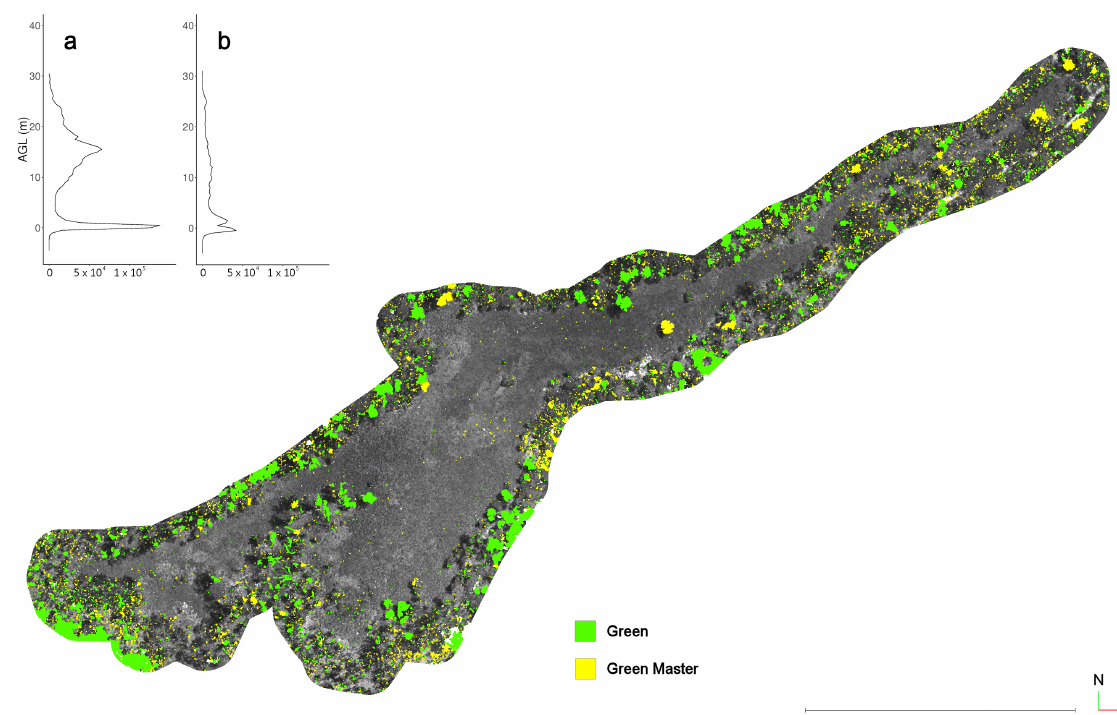
Figure 9. (main) Summer T2 dense point cloud differences between the green band alone (green) and the green band as master (yellow), highlighted against dense point features of both products separated by less than 0.5 m. The vertical frequency of unique features in ( a ) the green band only and ( b ) the green band master processed with identical settings.